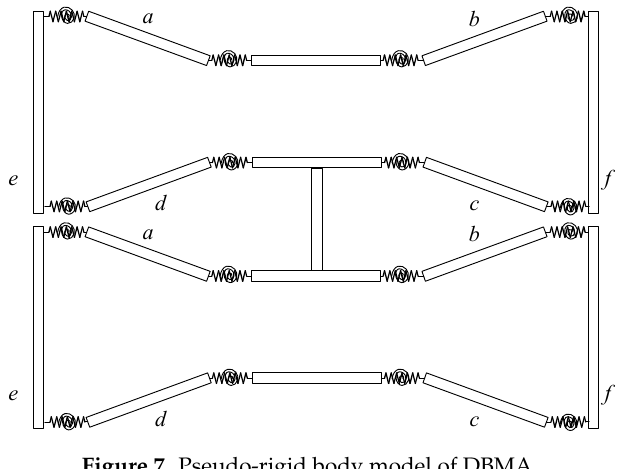
Figure 7. Pseudo-rigid body model of DBMA.